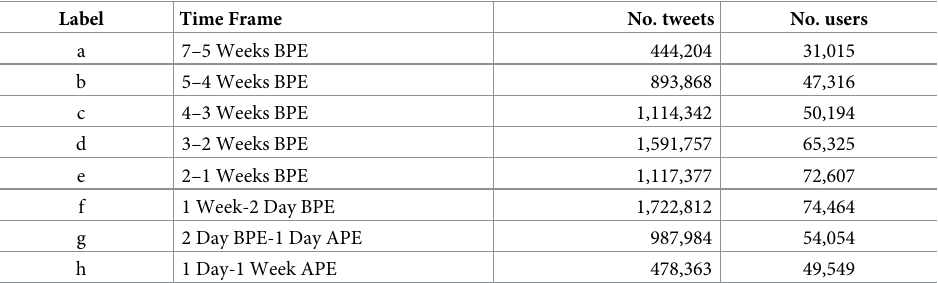
Table 1. The different time frames of data collection are listed with the amounts of users and tweets collected dur- ing this time. BPE and APE stand for before and after presidential election respectively.